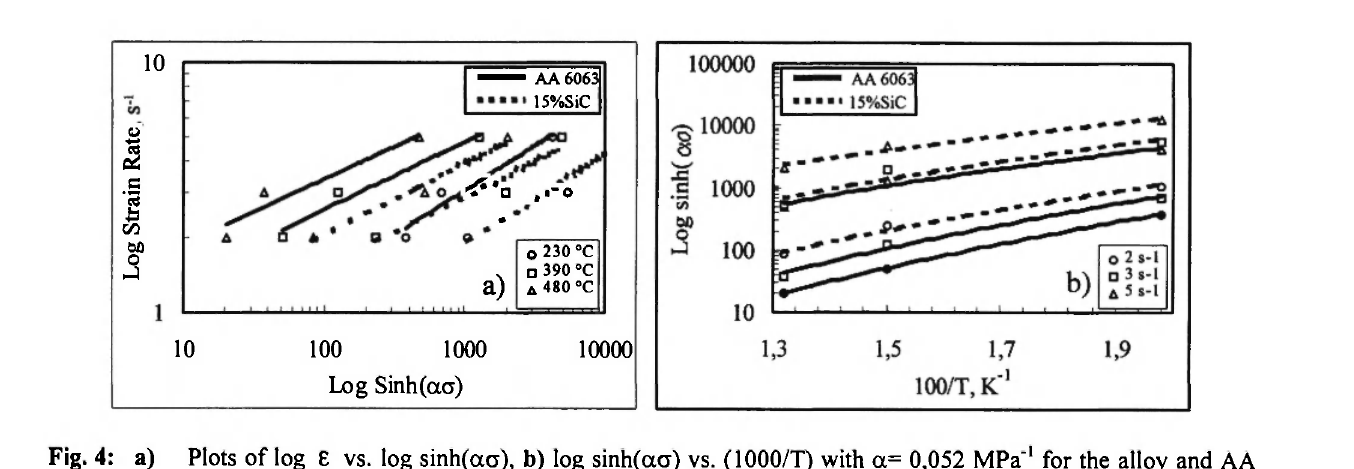
Fig. 4: a) Plots of log ε vs. log sinh(aa), b) log sinh(aa) vs. (1000/T) with <x= 0,052 MPa' 1 for the alloy and AA 6063/15%SiC composite.